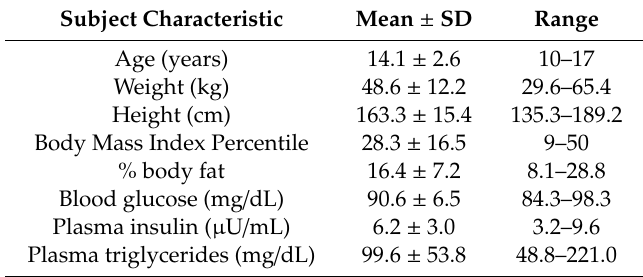
Table 1. Participant anthropometric characteristics at study baseline ( n =